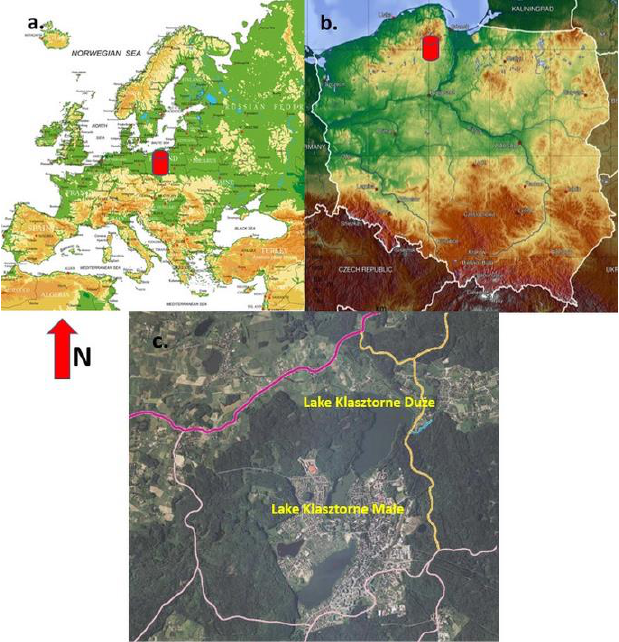
Figure 1. Study area: ( a ) location of research lakes in Europe, ( b ) location of research lakes in Poland and ( c ) lake catchment.